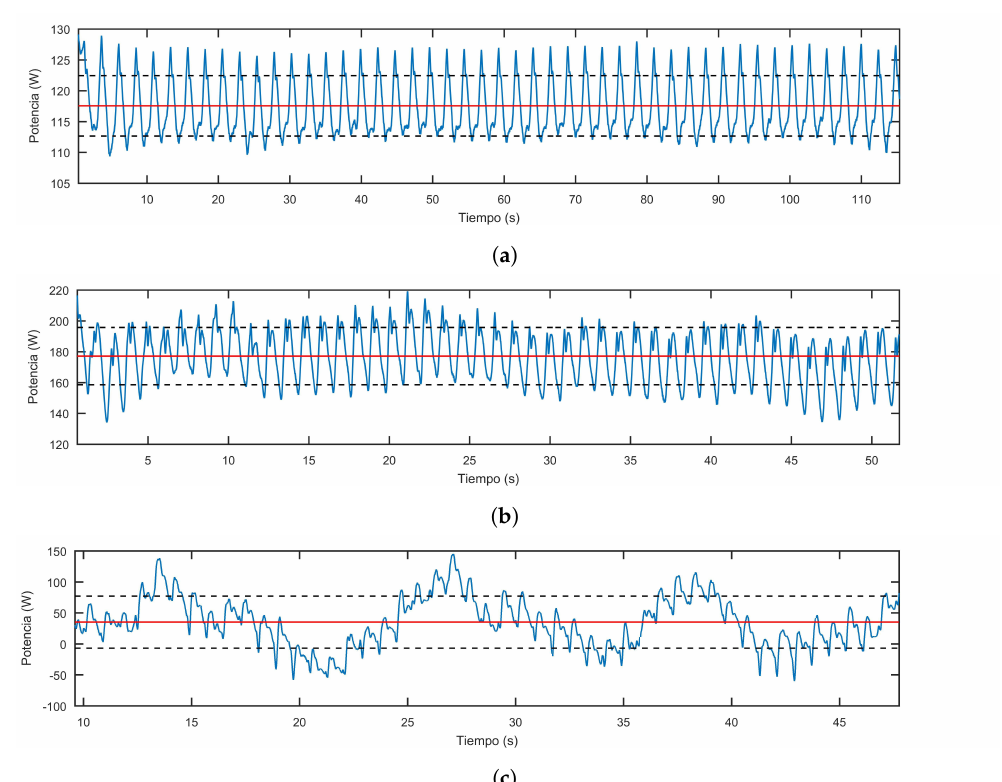
Figure 13. Instantaneous power over 4 turns of the HPM for three operating points: ( a ) Q = 58.9 L/s, ( b ) Q = 97.8 L/s and ( c ) Q = 120 L/s.